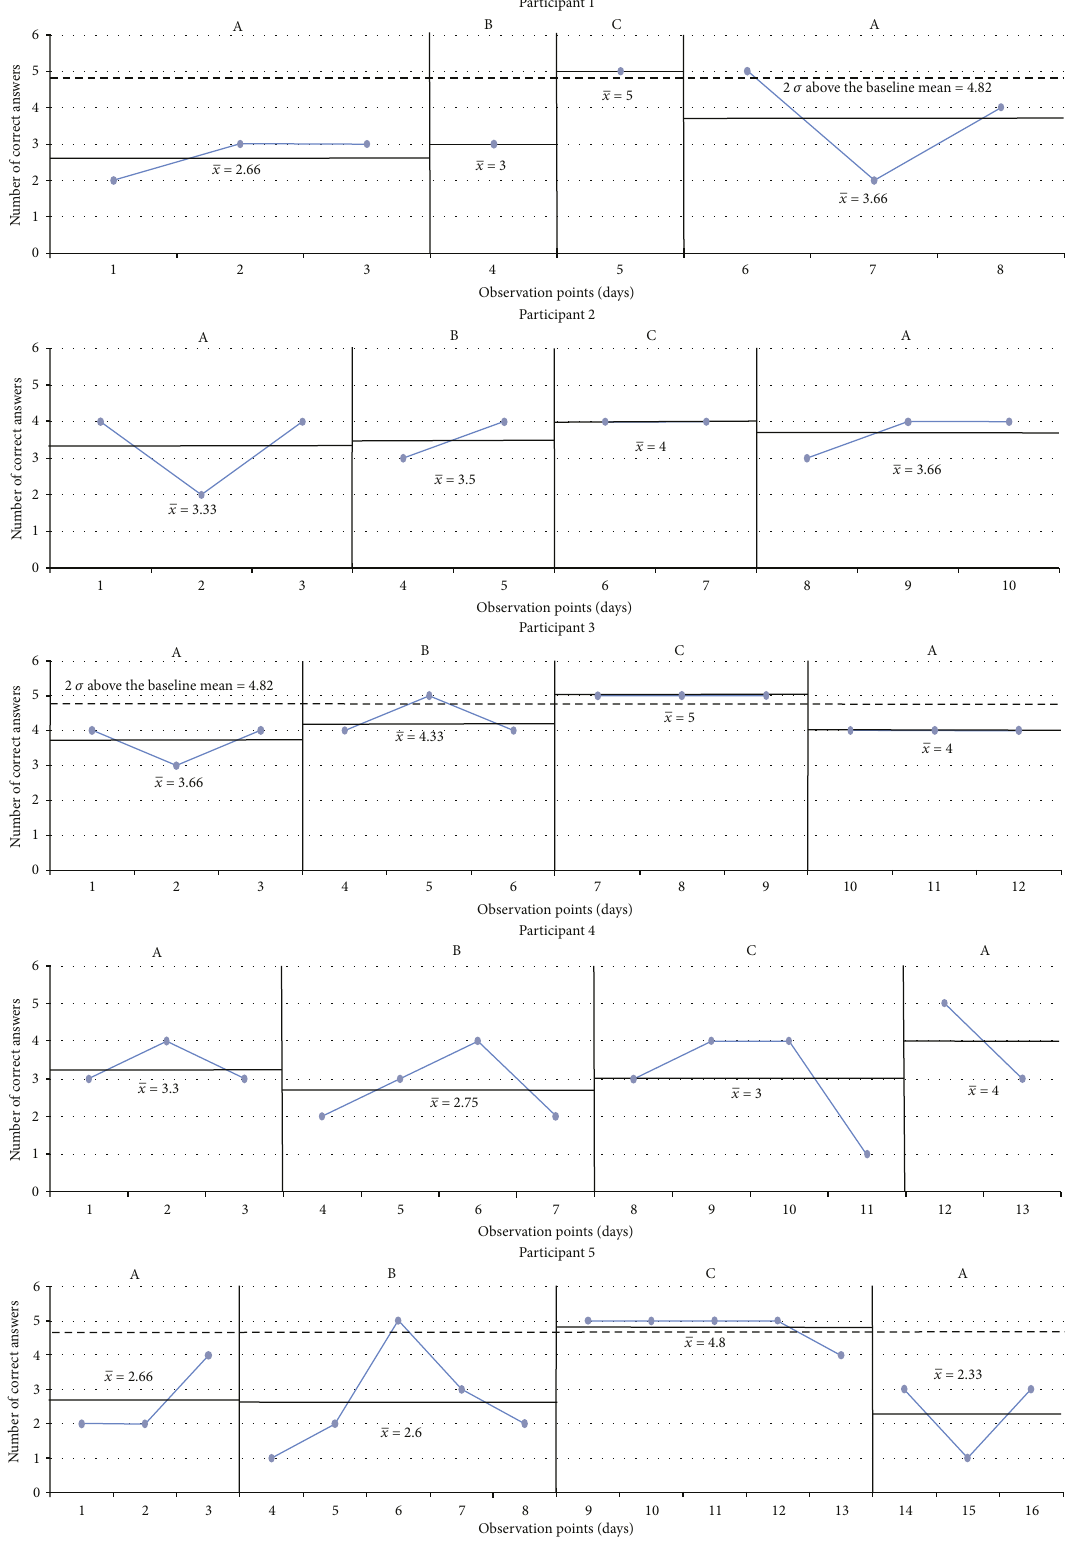
Figure 3: The last light on. A: baseline; B: sham tDCS; C: tDCS; x -axis: observation points in days; y -axis: number of correct answers. Scores are shown, along with black lines marking the average of each phase and with a black dotted line starting at the corresponding baseline marking 2-standard deviation (2 σ ) when there is statistically signi fi cant di ff erence (participants 1, 3, and